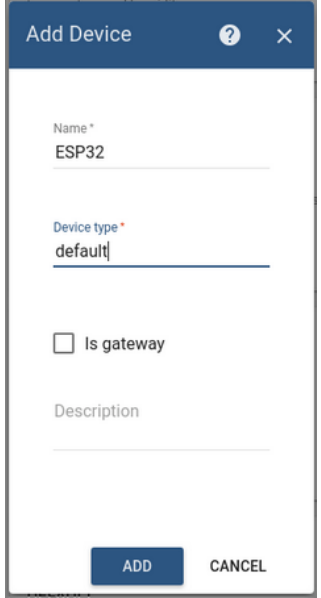
Figure 4. Setting up the ThingsBoard platform to operate according to the information received from ESP32, IoT module added to ThingsBoard and Multi-sensorial